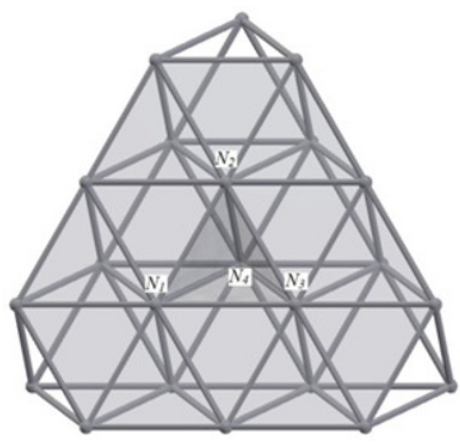
Figure 2. Three dimensional finite element mesh after removal of the element E 1